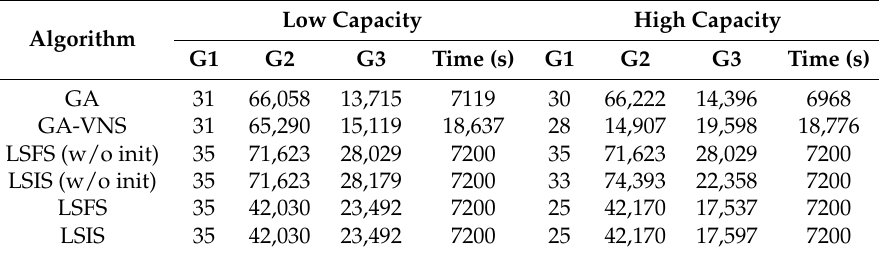
Table 3. Result of Case 3 (low capacity: 2000; high capacity: